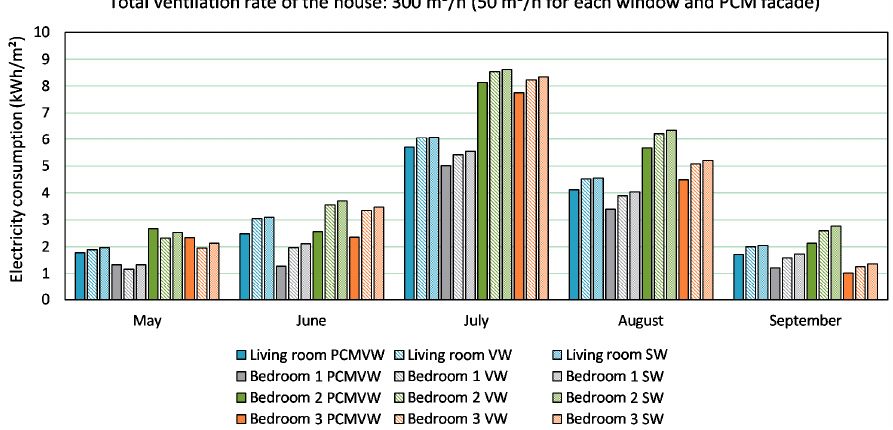
Figure 14. The heat pump electricity consumption of each room during the summer period at a ventilation air flow rate of 300 m 3 /h.